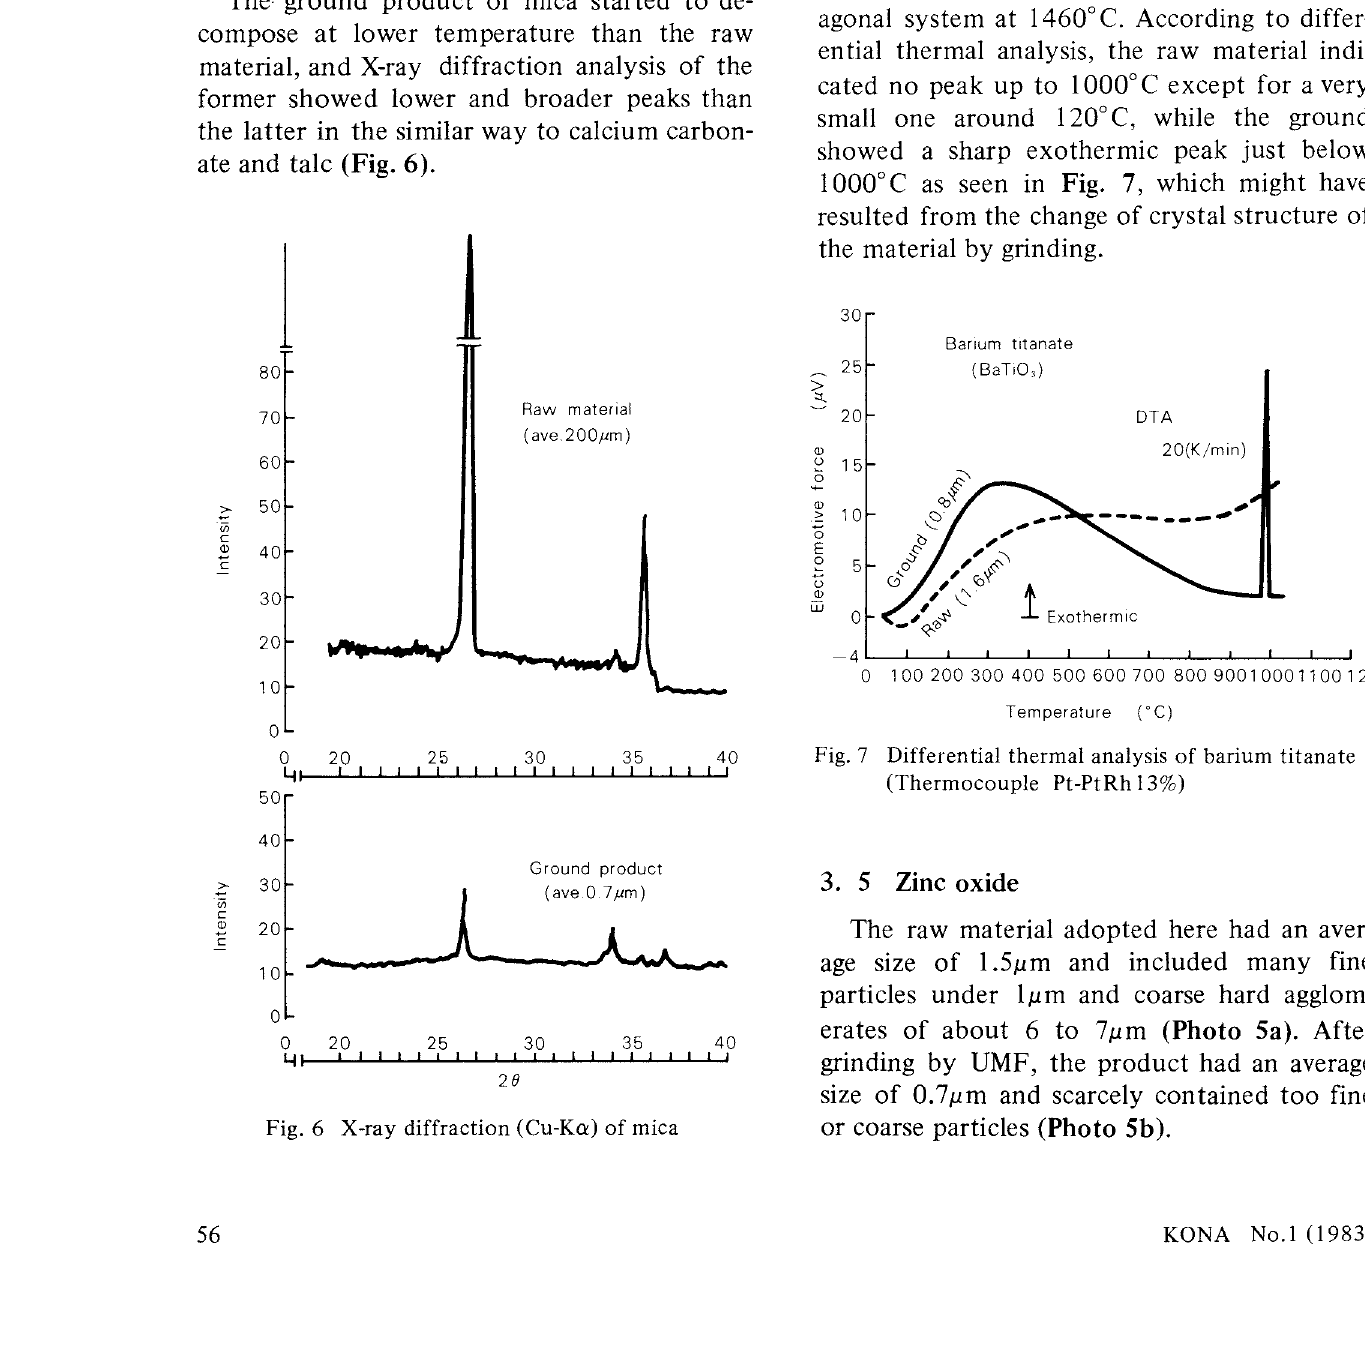
Fig. 6 X-ray diffraction (Cu-Ka:) of mica